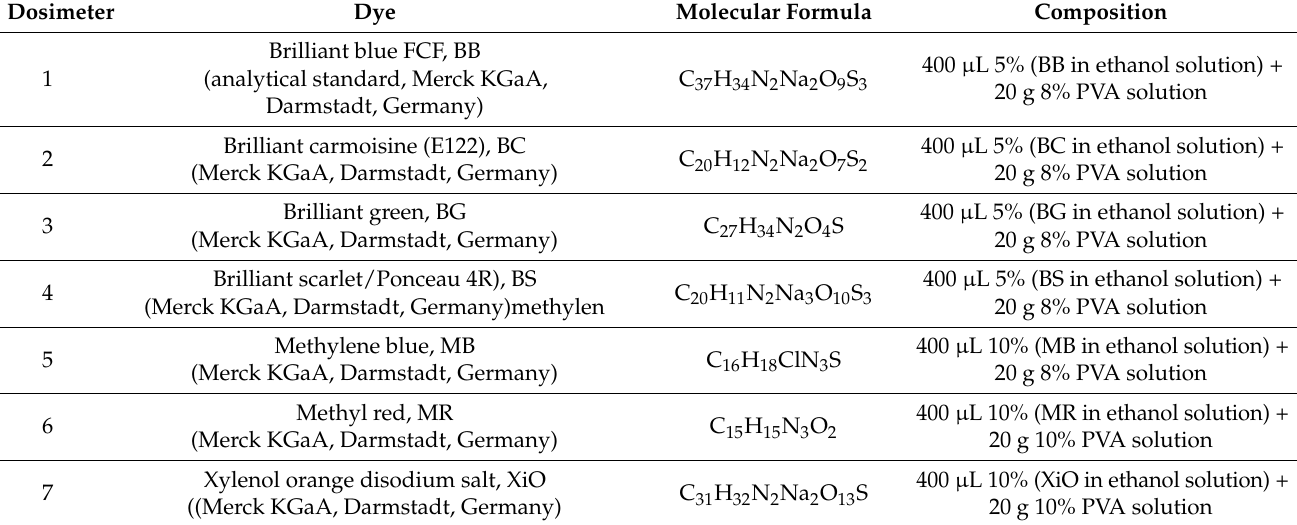
Table 1. Chemical composition of prepared different PVA-dye